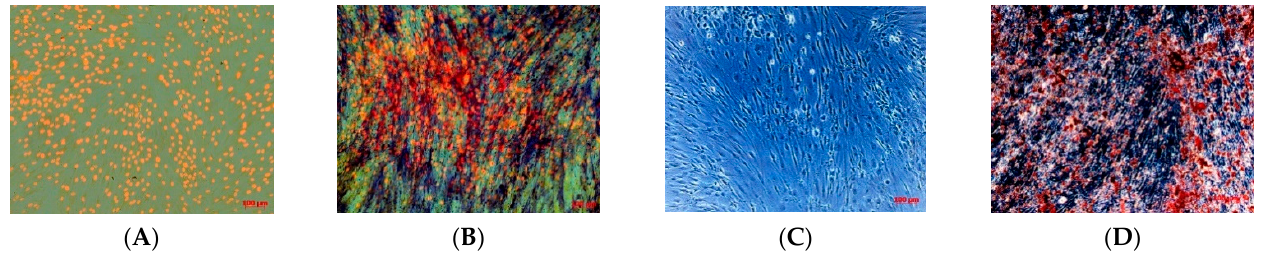
Figure 4. Osteogenic differentiation assay_ALP and HA. Osteogenic differentiation_ALP at 0 days ( A ) and after 10 days ( B ) of induction by cytochemical staining for ALP with Fast Blue BB. Blue shows the ALP + cells; in orange/red the nucleus counterstained by Propidium Iodide. Composite observation in brightfield and fluorescence. Osteogenic differentiation_HA at 0 days ( C ) and after 20 days ( D ) of induction by cytochemical staining for Hydroxyapatite (HA) with Alizarin Red S. The cells only are contrasted in blue/grey, and the grainy deposits of HA are stained in red. Observation in phase contrast. Original magnification: 20×.